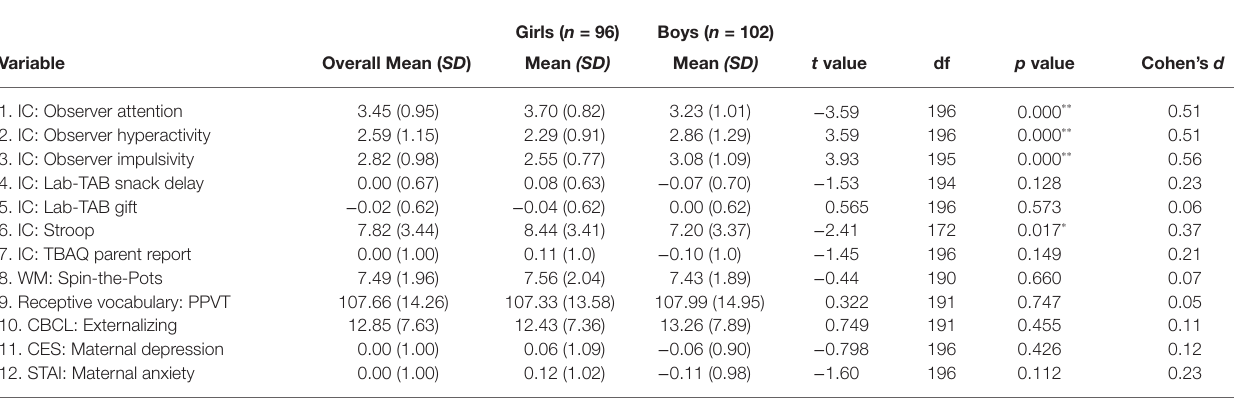
TABLE 1 | Descriptive statistics and gender differences among study